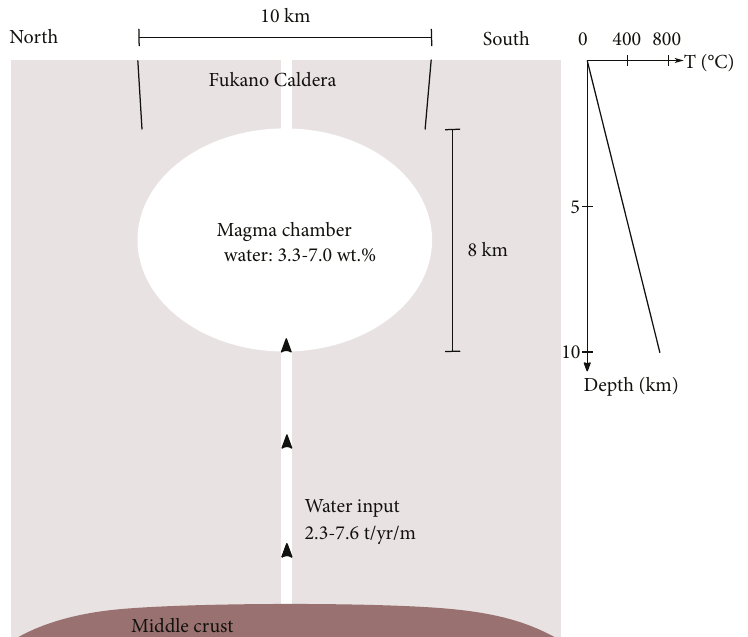
Figure 8: Depiction of the estimated amount of water input to the magma chamber based on MI data from this study. The percentage of water in the magma chamber is 3.3 – 7.0wt.% (6.8 × 10 13 to 2.3 × 10 14 kg), which accumulated during a 3Myr period along the ~ 10km arc length of the chamber. The right-hand part of the diagram shows the geothermal gradient of Shirasawa Caldera (located immediately to the NE of Fukano Caldera), and its surrounds (70 ° C/km)